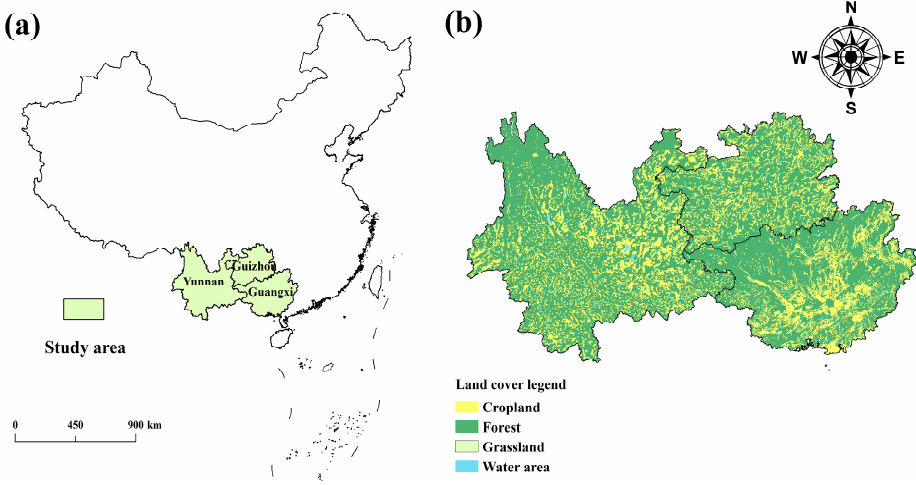
Figure 1. ( a ) Location of the study area. ( b ) Land use types.